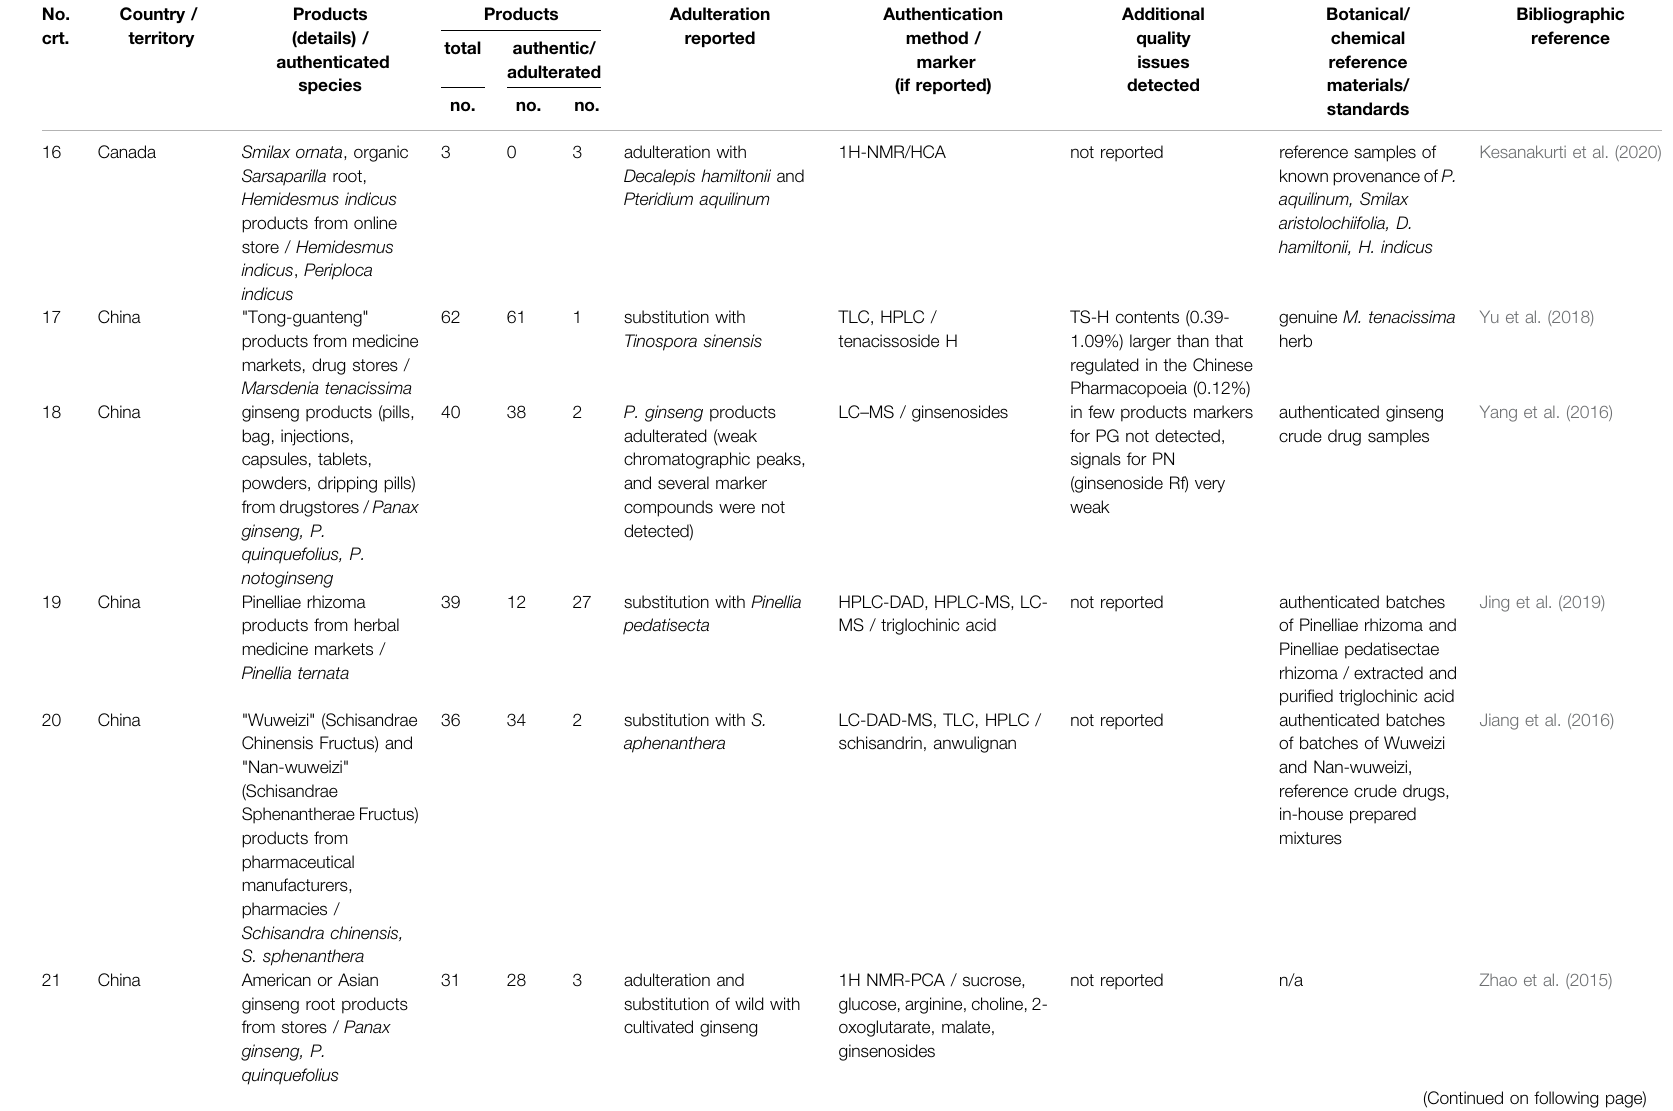
TABLE 1 | ( Continued ) The authenticity of the chemically authenticated commercial herbal products at global level. No.